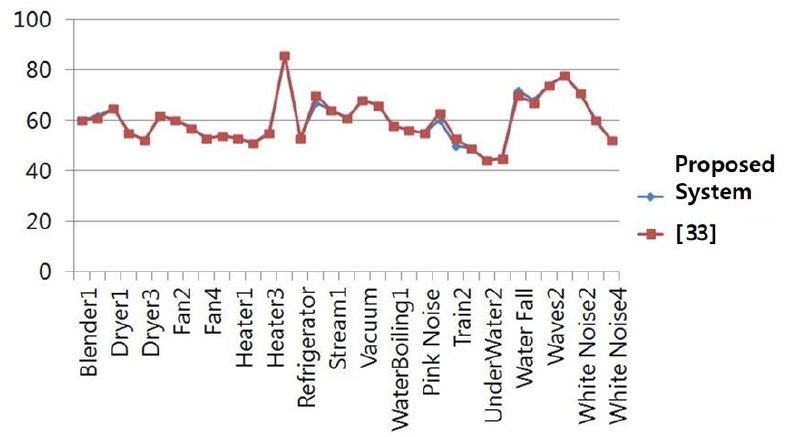
Figure 9. Measurements by the proposed system and from reference [33].